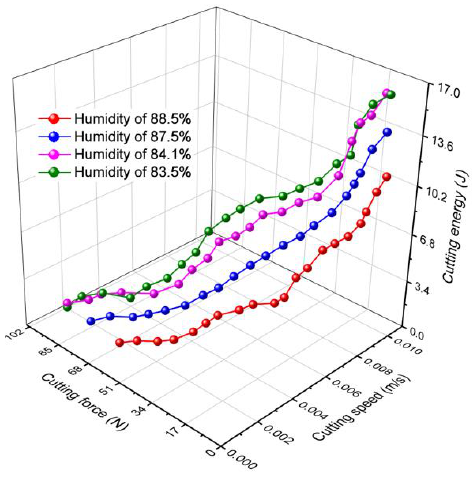
Figure 3. Variation in cutting energy for unpeeled apples with different humidity levels based on cutting speed.